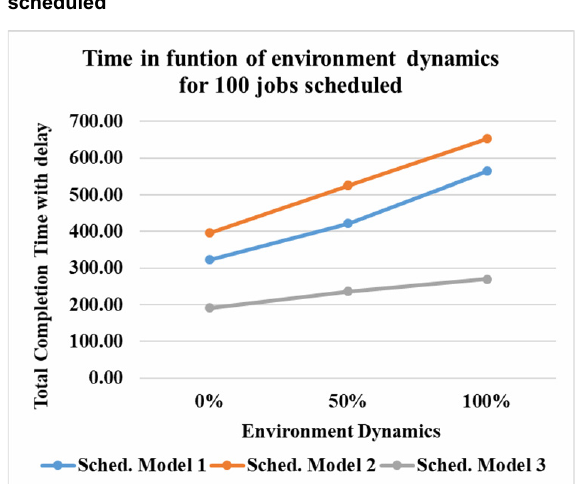
Figure 10. Effect of environment dynamics in total completion time over the 3 scheduling models for 100 jobs